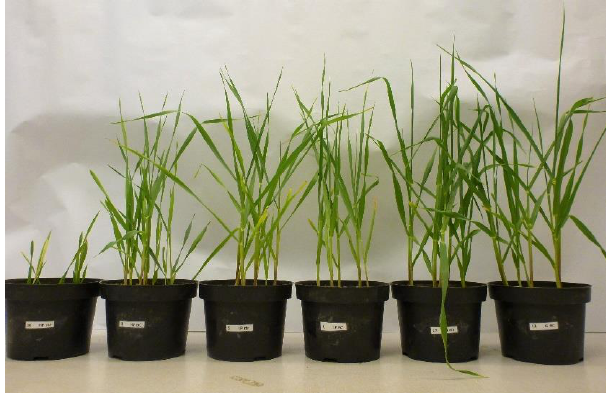
Figure 1. Pot experiment showing differences in barley (Hordeum vulgare L .) growth between soils and treatments 4 weeks after germination, from left to right: highly polluted soil (control), highly polluted soil with 2% ( w / v ) biochar, weakly polluted soil (control), weakly polluted soil with 2% ( w / v ) biochar, unpolluted soil (control), unpolluted soil with 2% ( w / v ) biochar. Note that only one of the triplicates of each treatment is